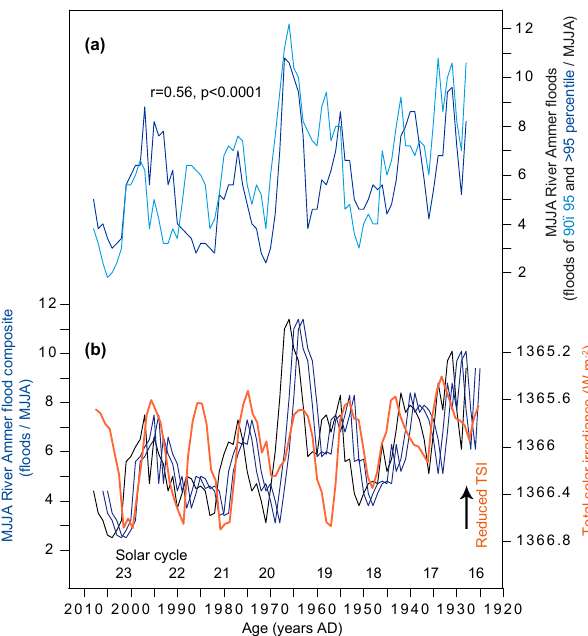
Figure 2. River Ammer flood frequency in the discharge record and solar activity. (a) Frequency of River Ammer floods during MJJA with discharges between the 90th and 95th percentile as well as above the 95th percentile. (b) River Ammer flood frequency com- posite (see Sect. 2) and total solar irradiance (TSI) during solar cycles 16–23 (Lean, 2000). The black line indicates the original River Ammer flood frequency composite. The blue lines represent the River Ammer flood frequency composite shifted for 2 and 3 years into the past, revealing significant correlations with TSI (see Fig. 4). The River Ammer flood records were filtered using a 5-year running mean. Correlations were calculated using a random-phase test (Ebisuzaki,